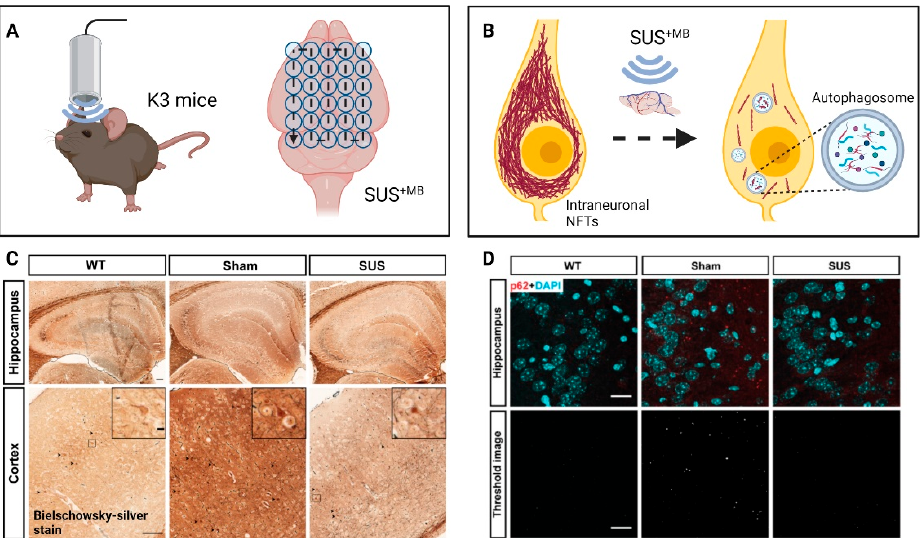
Figure 3. Impact of therapeutic ultrasound on Tau pathology. ( A ) The scanning ultrasound (SUS) path of the ultrasound beam is shown as the energy is applied to Tau transgenic K3 mice. ( B ) SUS with microbubbles (SUS +MB ) clears Tau via the activation of neuronal autophagy. ( C ) Mice treated with SUS +MB show reduced numbers of neurofibrillary tangle (NFT)-like inclusions detected by Bielschowsky-silver stain compared to sham controls. ( D ) The number and size of p62-positive puncta decrease upon SUS +MB treatment compared to sham mice, indicative of induction of autophagy. (A) and (B) were created with BioRender.com. Figures (C) and (D) are taken from [66]. Scale bar: 20 µ m.